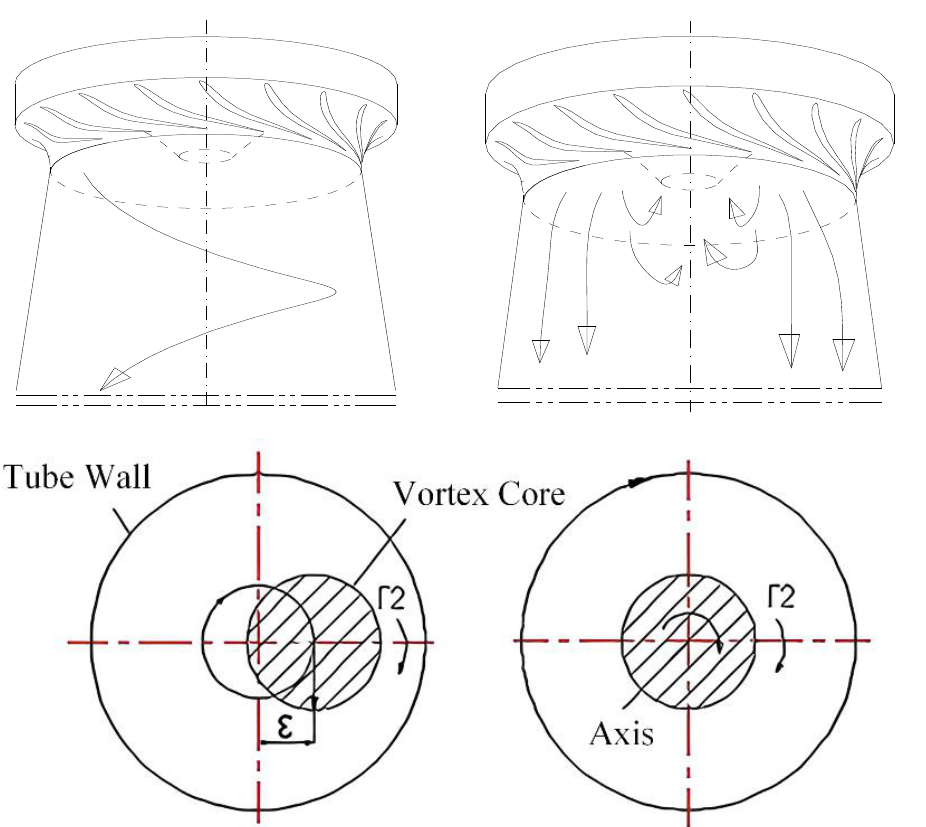
Figure 4. Schematic diagram of vortex motion in axial and radial sections in draft tube [19].